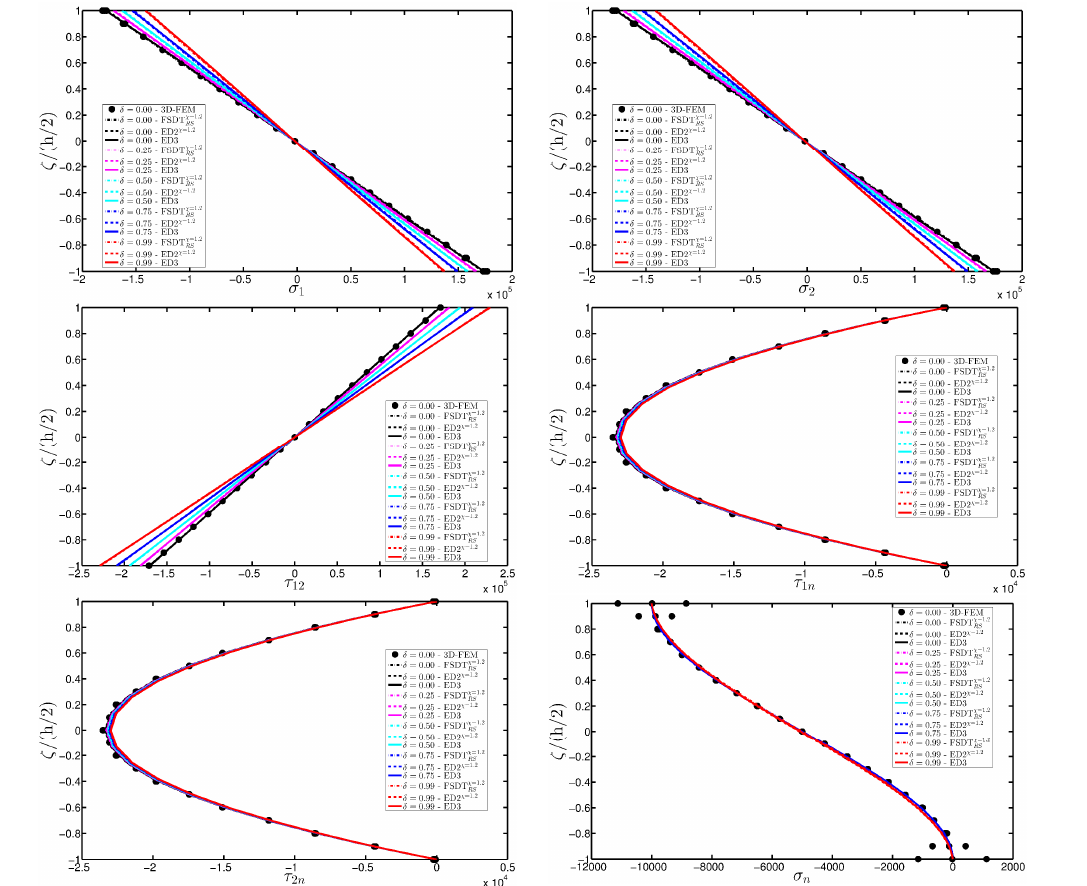
Figure 8. Through-the-thickness profiles of stress components [Pa] for the CCCC isotropic square plate computed at the point A for different HSDTs. The effect of the damage is investigated by varying the parameters of the function Gau-2.